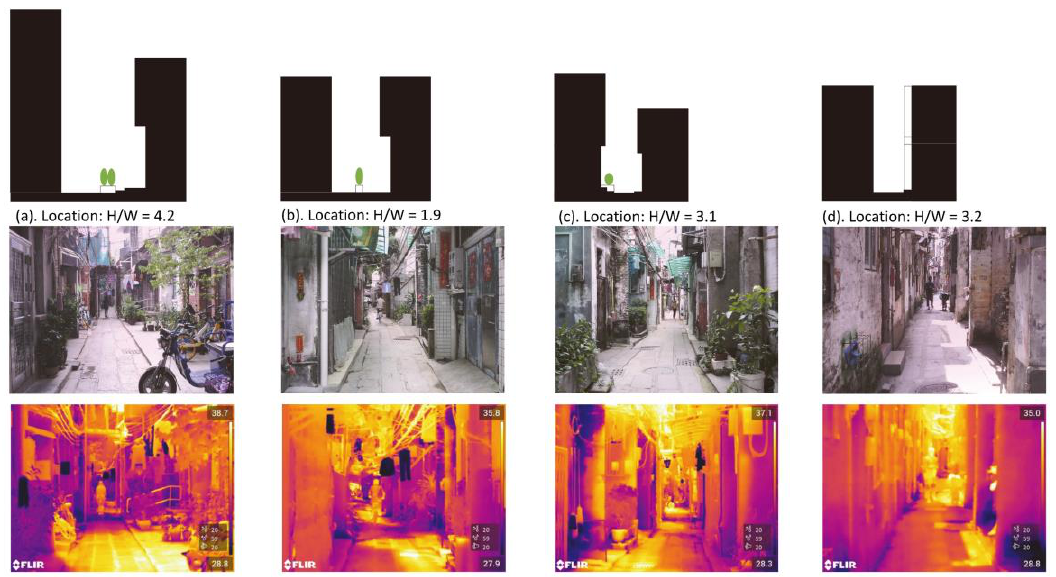
Figure 13. Thermal images of the study street in summer. (Photo by the students.).